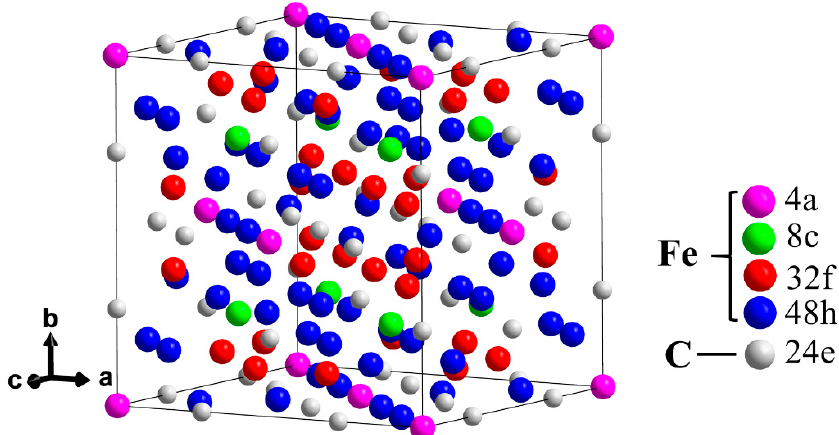
Figure 1. (Color online) Schematic crystal structure of Fe 23 C 6 with five nonequivalent Wyckoff sites, wherein the metal sites are occupied by Fe atoms, and C atoms occupy the 24e sites.